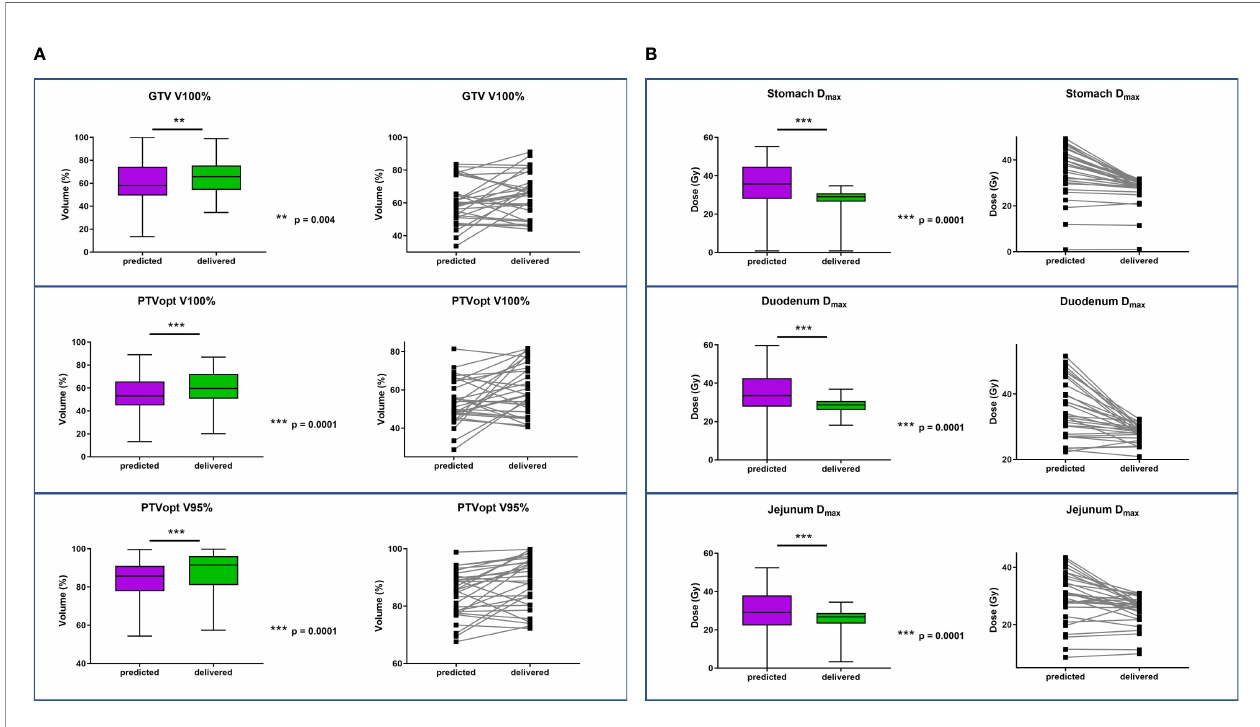
FIGURE 2 | Dosimetric comparison between predicted and adapted plans. (A) Target volumes coverage (GTV V100%, PTVopt, V100% and PTVopt V95%). (B) OAR sparing (Dmax to stomach, duodenum, and jejunum). The three images on the left part of the fi gures represent the 150 predicted fractions vs. 150 adapted fractions (5 fractions for 30 patients). Whiskers show minimal to maximal values, and boxes show the mean values with standard deviations. The three images on the right part of the fi gures represent the variation for each patient (one line represents one patient) from the predicted values (left) to the adapted values (right). In order to limit the number of lines (30 lines) and to make the fi gure readable, we have calculated and plotted the average values of the 5 predicted plans (left) and the average values of the 5 adapted plans (right). GTV, gross tumor volume; PTVopt, planning target volume optimized; OAR, organ at